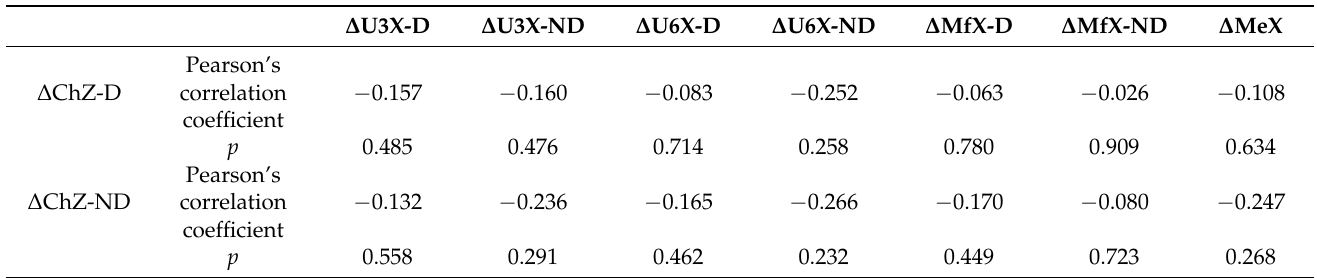
Table 5. Correlation between the vertical changes in the cheilions ( ∆ ChZ-D/ND) and the changes in other variables in the transverse direction.